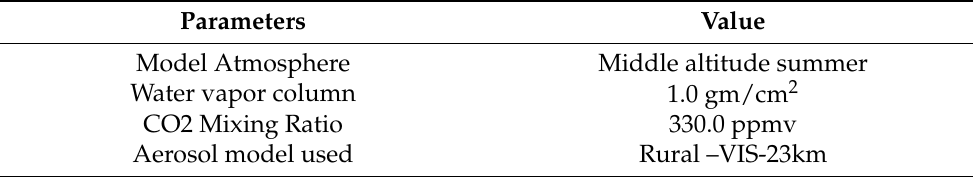
Table 1. Main parameters of MODTRAN used to calculate transmittance.